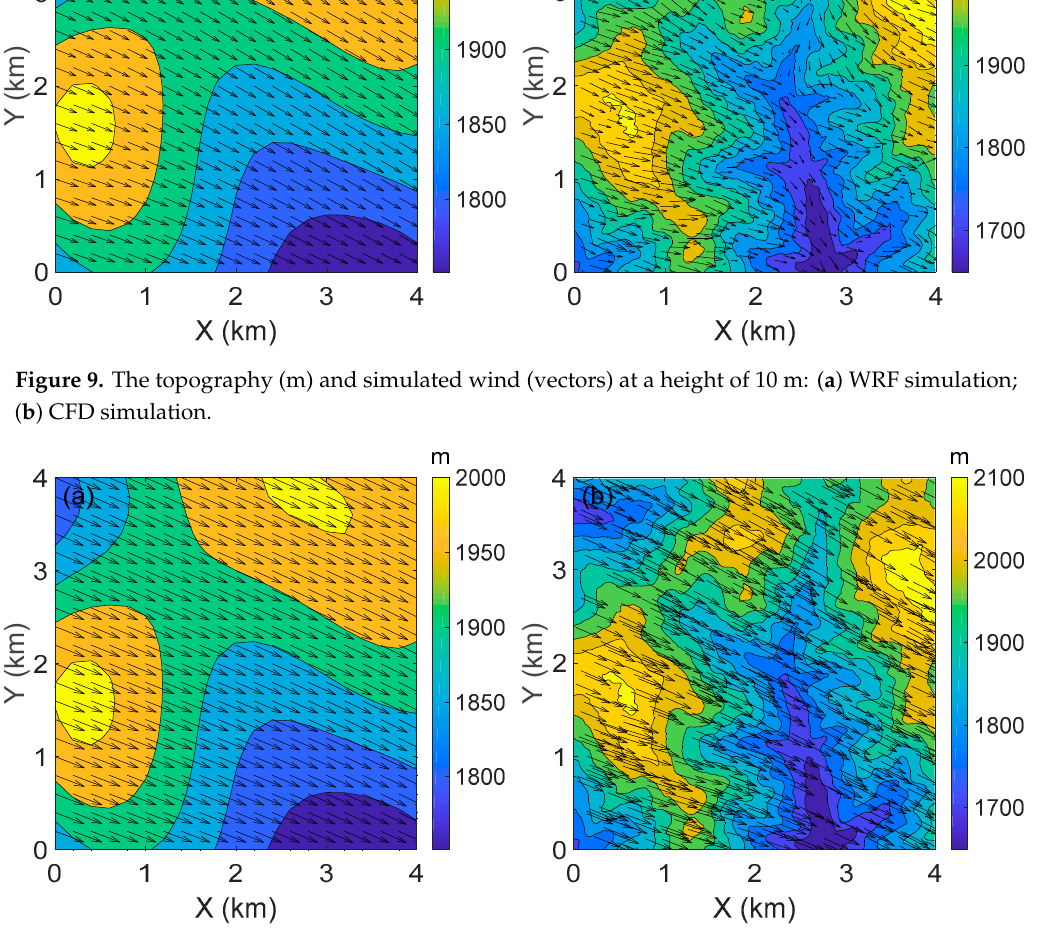
Figure 10. The topography (m) and simulated wind (vectors) at a height of 400 m: ( a ) WRF simulation; ( b ) CFD simulation.